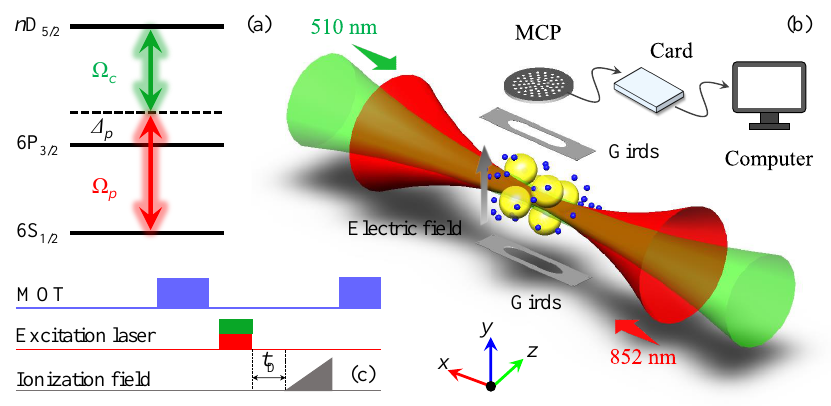
Figure 1. ( a ) Two-photon excitation diagram. The first photon, Ω p , drives the lower transition, (cid:48) = 5 (cid:105) , and its frequency is blue shifted ∆ | 6 S = 4 (cid:105) → | 6 P p /2 π = 360 MHz from the 1/2 , F 3/2 , F state | 6 P 3/2 , F (cid:48) = 5 (cid:105) using a double-pass acousto-optic modulator (AOM). The second photon, Ω c , couples the Rydberg transition | 6 P 3/2 , F (cid:48) = 5 (cid:105) → | nD 5/2 (cid:105) . ( b ) Sketch of an experimental setup. The coupling laser λ c = 510 nm and probe laser λ p = 852 nm are overlapped in the MOT center to excite ground atoms (small blue balls) to Rydberg states (large yellow balls). Free ions due to the autoionization are detected with the MCP detector and recorded with a computer. ( c ) Experimental timing. After switching off MOT beams, the two-photon excitation lasers are turned on to excite cesium ground atoms to the Rydberg state. A ramped electric field is finally applied to ionize the Rydberg atoms after interaction time t D and drive free ions and Rydberg ions to the MCP detector.The rising time of the ramped field is 3 µ s, and the peak value is defined as E ion .